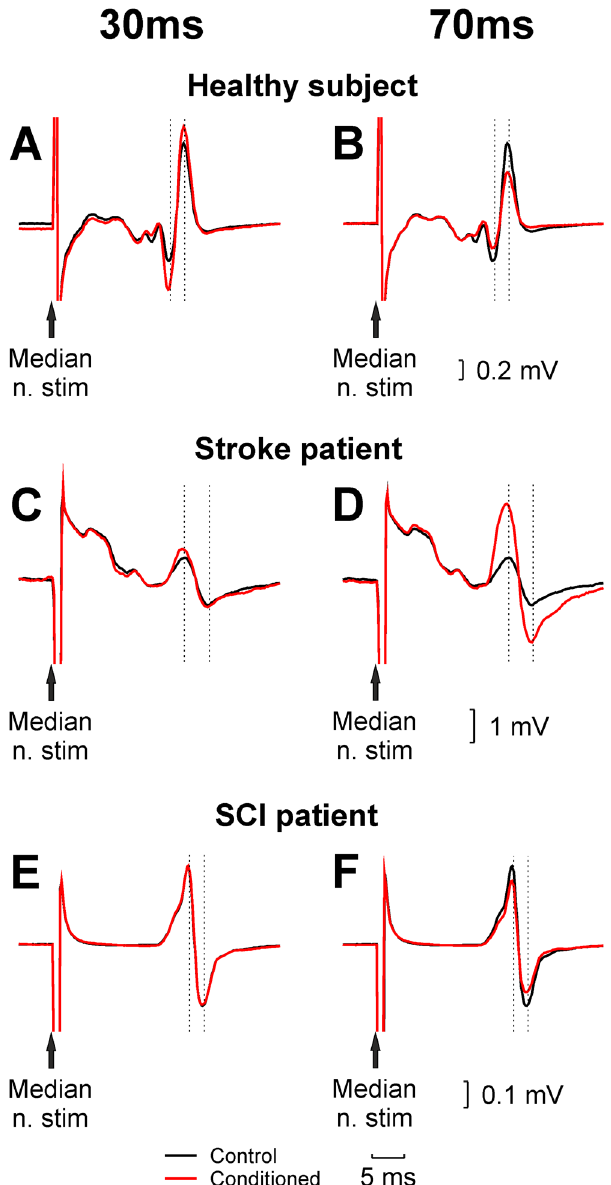
Figure 1. Example H-reflex recordings from the FCR muscle. Each panel shows an unconditioned H-reflex (black), and an H-reflex conditioned by preceding stimulation of the ECR muscle (red). Results are shown for a single healthy subject ( A , B ) patient with stroke ( C , D Ashworth score 2) and spinal cord injury ( E , F Ashworth score 0). Left panels ( A , C , E ) used a conditioning interval of 30 ms, which generates facilitation in healthy subjects; right panels ( B , D , F ) used an interval of 70 ms, at which the reflex is suppressed in healthy